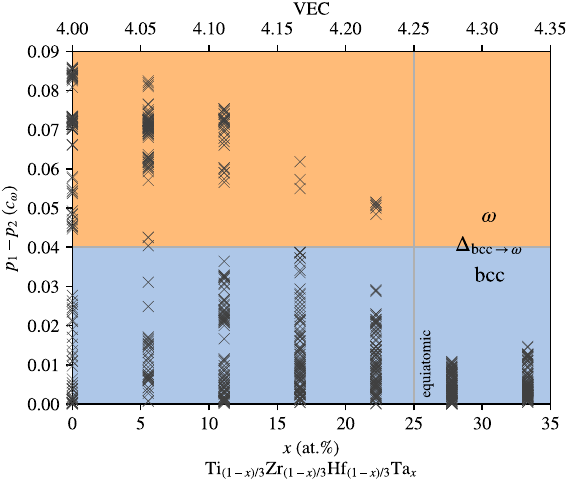
Fig. 3 Values of Δ p = p 1 − p 2 to distinguish bcc and ω -like structures for the pseudobinary Ti (1 − x )/3 Zr (1 − x )/3 Hf (1 − x )/3 Ta x alloys relaxed from the ideal bcc lattice sites at 0 K. For each composition, the results from all the SQS models and from all the volumes are